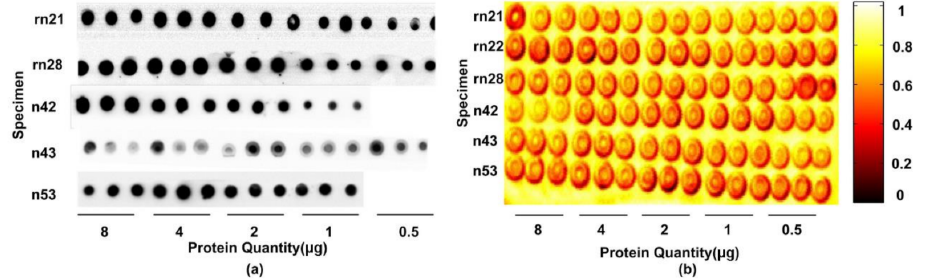
Figure 4. The imaging of the membrane: ( a ) the dot blot result, ( b ) the pseudo-color image of gray image formatted by the relative THz energy integration of transmission spectrum pixel by pixel. Reprinted from